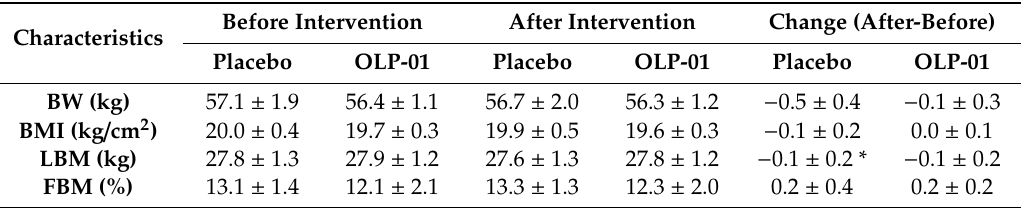
Table 2. Body Composition of